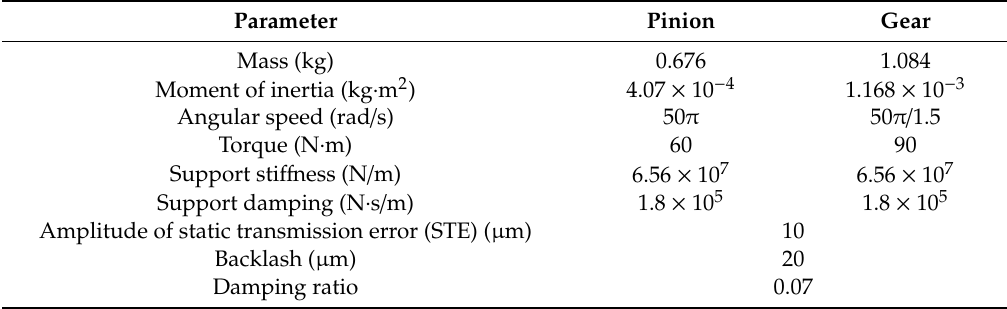
Table 3. Main parameters in dynamic